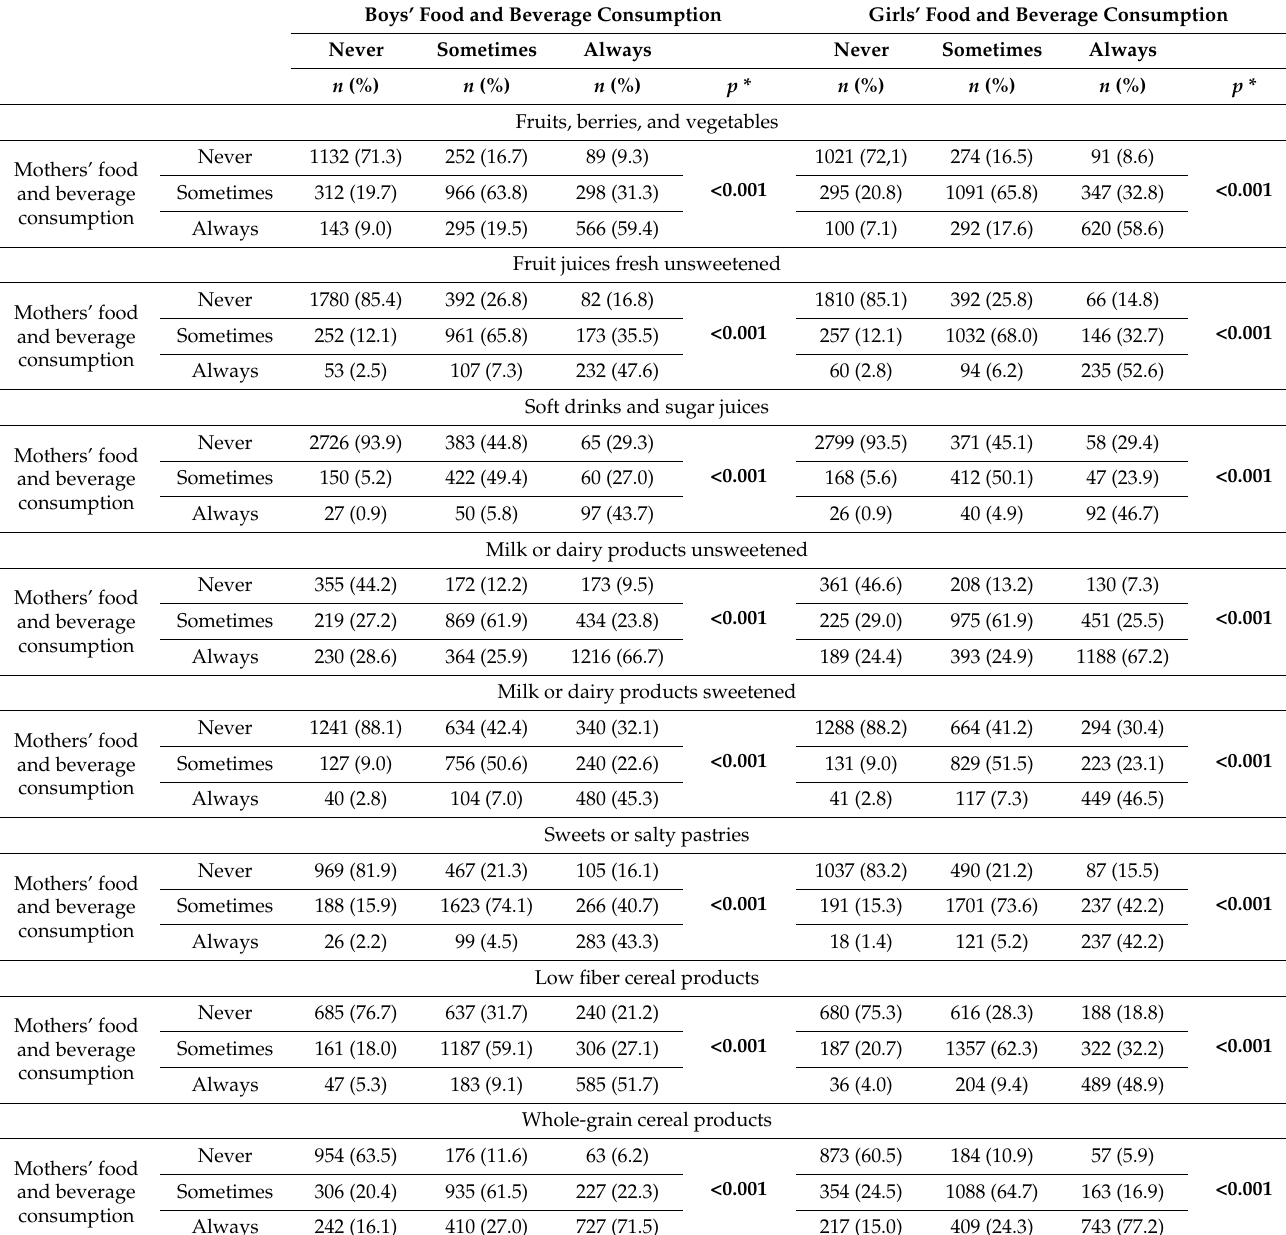
Table 7. Frequency of foods and beverages consumption at breakfast between mothers and their